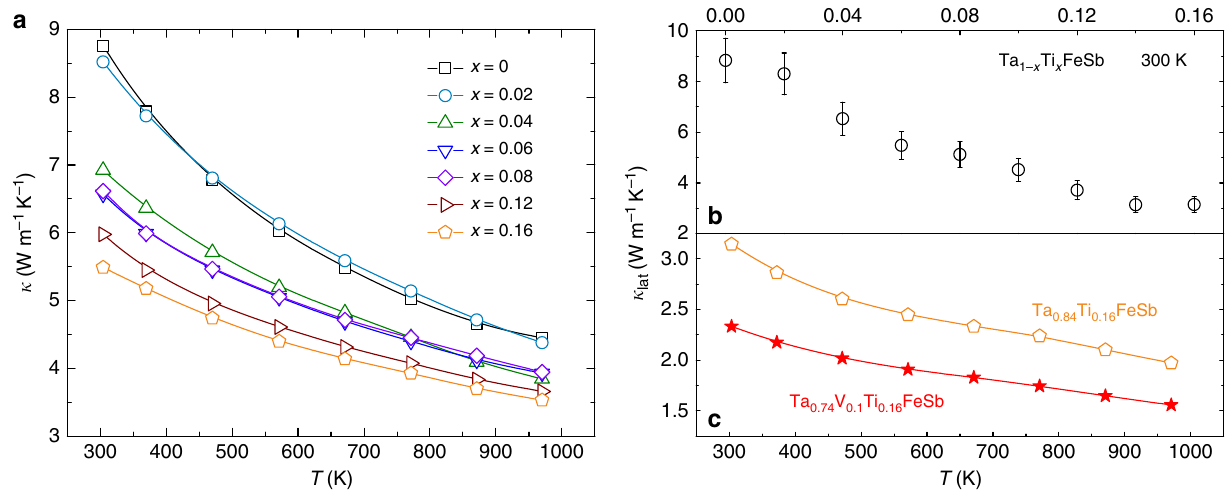
Fig. 4 Thermal conductivity of TaFeSb-based half-Heuslers. a Temperature-dependent thermal conductivity of Ta 1- x Ti x FeSb, b composition-dependent room-temperature lattice thermal conductivity of Ta 1- x Ti x FeSb, and c comparison of lattice thermal conductivity between Ta 0.84 Ti 0.16 FeSb and Ta 0.74 V 0.1 Ti 0.16